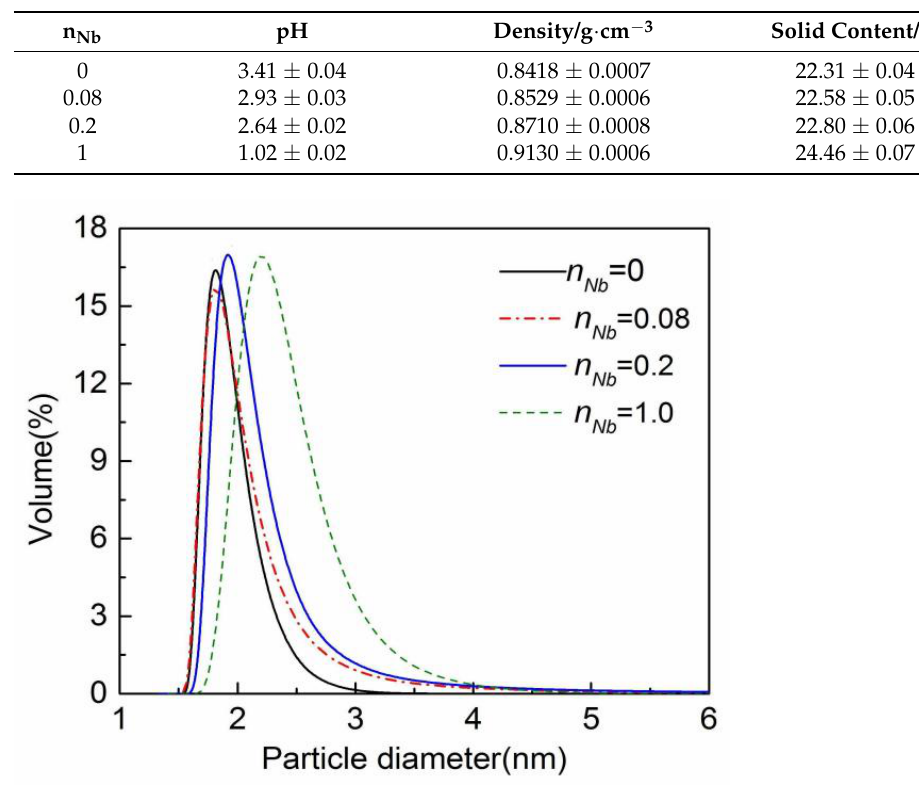
Table 1. The influence of n Nb on the pH value, density, and solid content of Nb/SiO 2 sol.